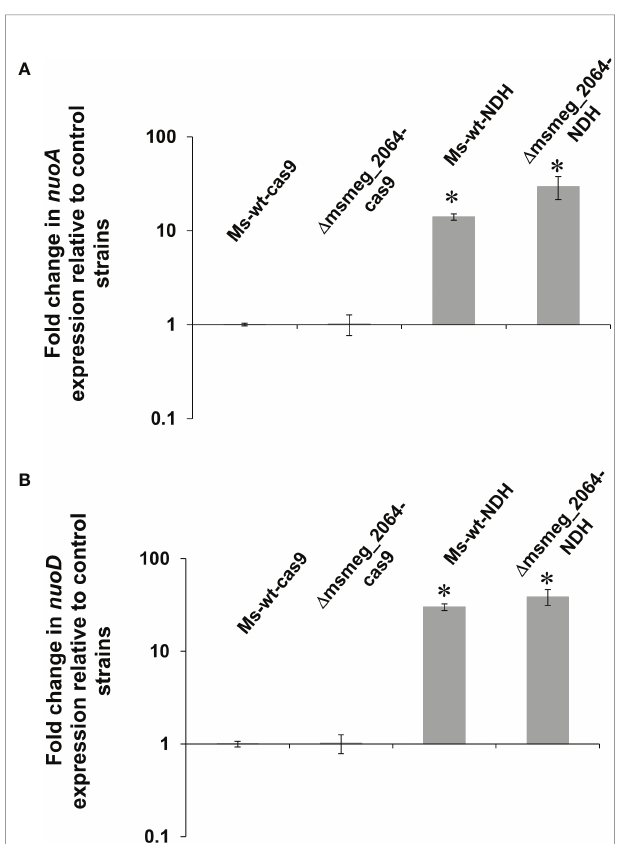
FIGURE 7 | Expression pro fi le of nuoA (A) and nuoD (B) genes in Mycobacterium smegmatis strains expressing depleted ndh . Mutant strains ndh CRISPRi/dCas9 (Ms-wt-NDH) and D msmeg_2064-ndh CRISPRi/dCas9 ( D msmeg_2064 -NDH) and control strains CRISPRi/dCas9 (Ms-wt-cas9) and D msmeg_2064 CRISPRi/dCas9 ( D msmeg_2064 -cas9) were grown in 7H9/AD broth for 16 h at 37°C with the addition of anhydrotetracycline. Transcript levels were determined using qRT-PCR and SYBR green chemistry. The expression levels of nuoA / nuoD were normalized to the sigA housekeeping gene and compared to the control strain. Statistical signi fi cance was determined using Student ’ s t-test (A) (* p < 0.001); (B) (* p <